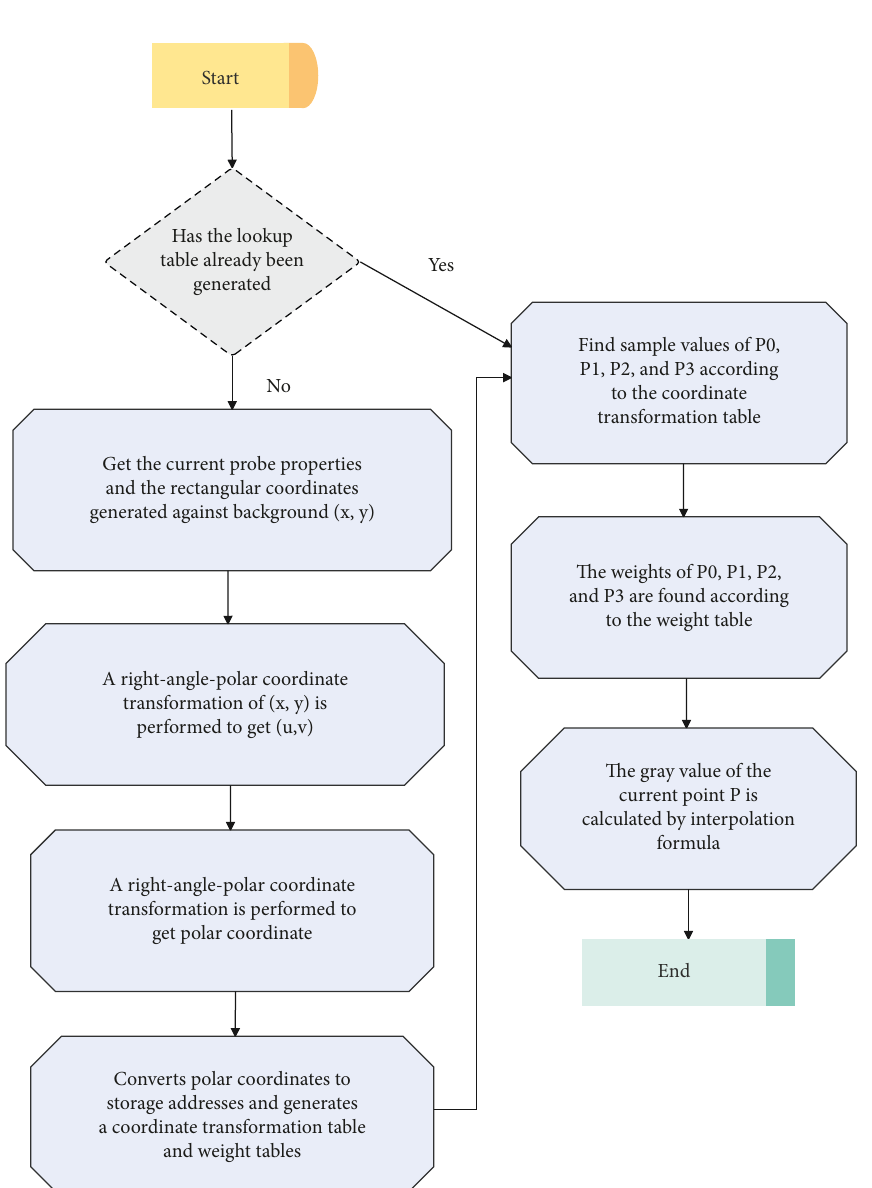
Figure 5: DSC flow